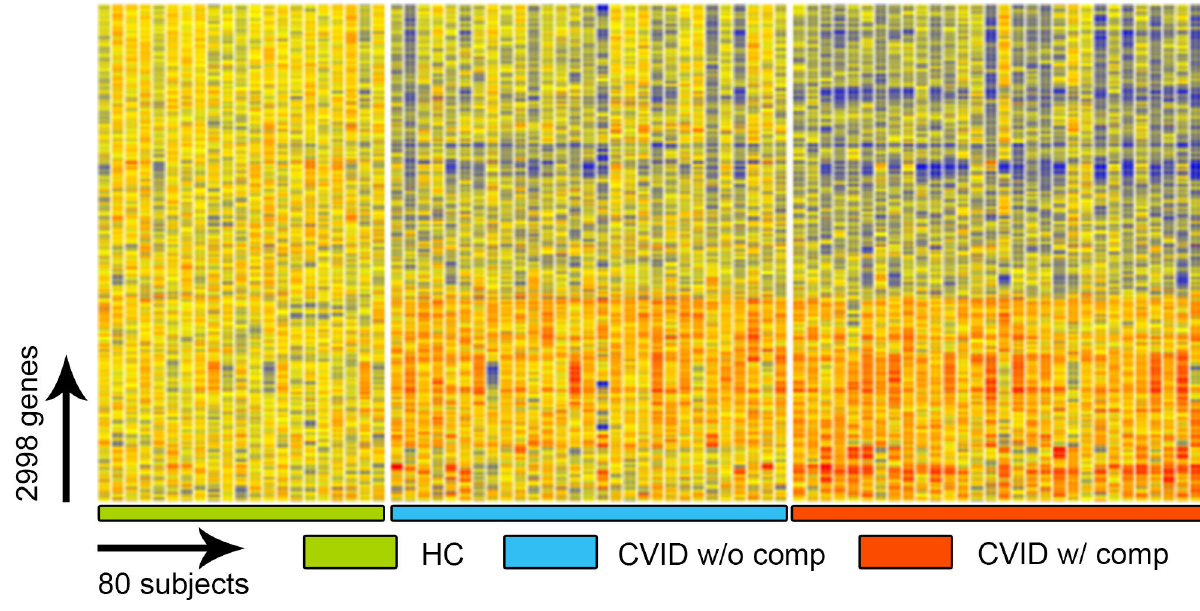
Figure 2. ANOVA test comparing CVID blood (training set) to healthy controls. The ANOVA test (FDR 0.05) identifies 2,998 transcripts differentially expressed in whole blood cells of CVID patients with and without inflammatory complications and healthy controls.